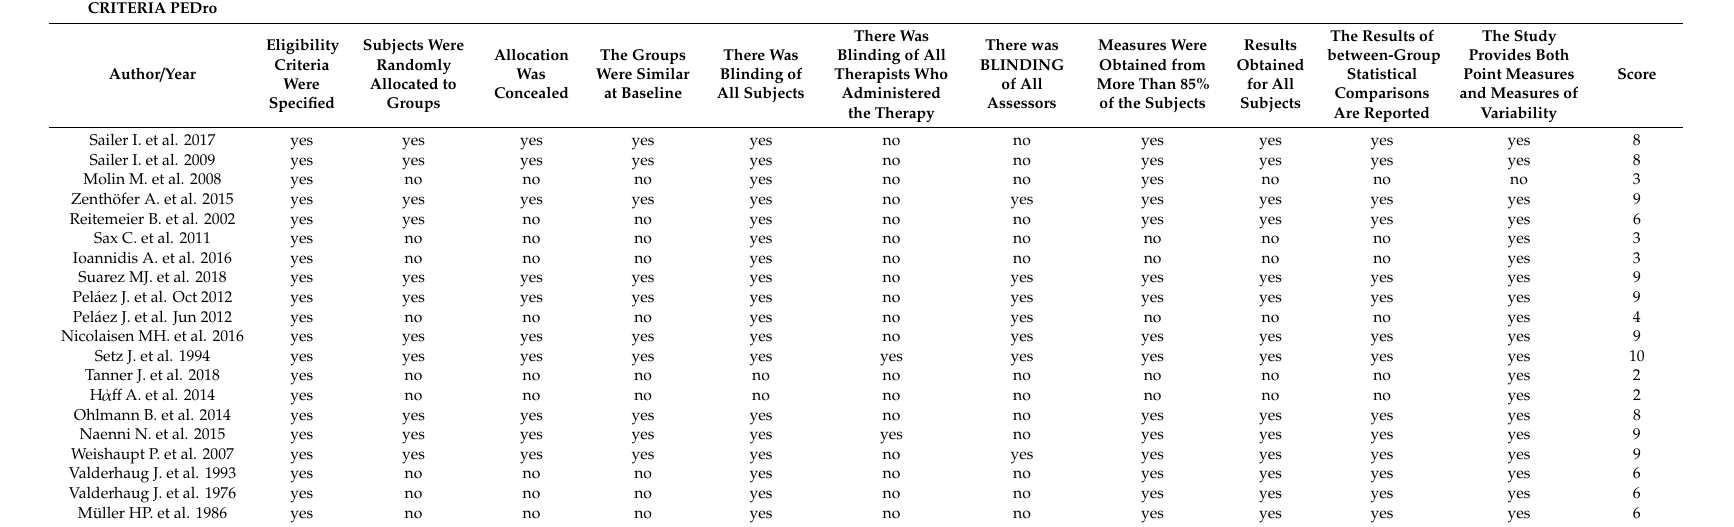
Table 2. Assessment of methodological quality according to PEDro